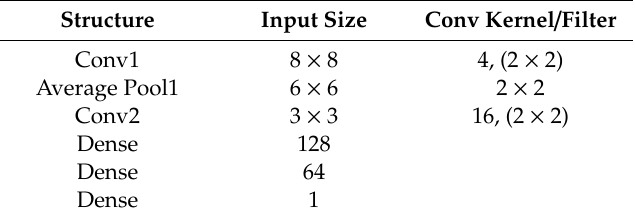
Figure 4. CNN data set division diagram. Table 1. CNN networks structure parameters.